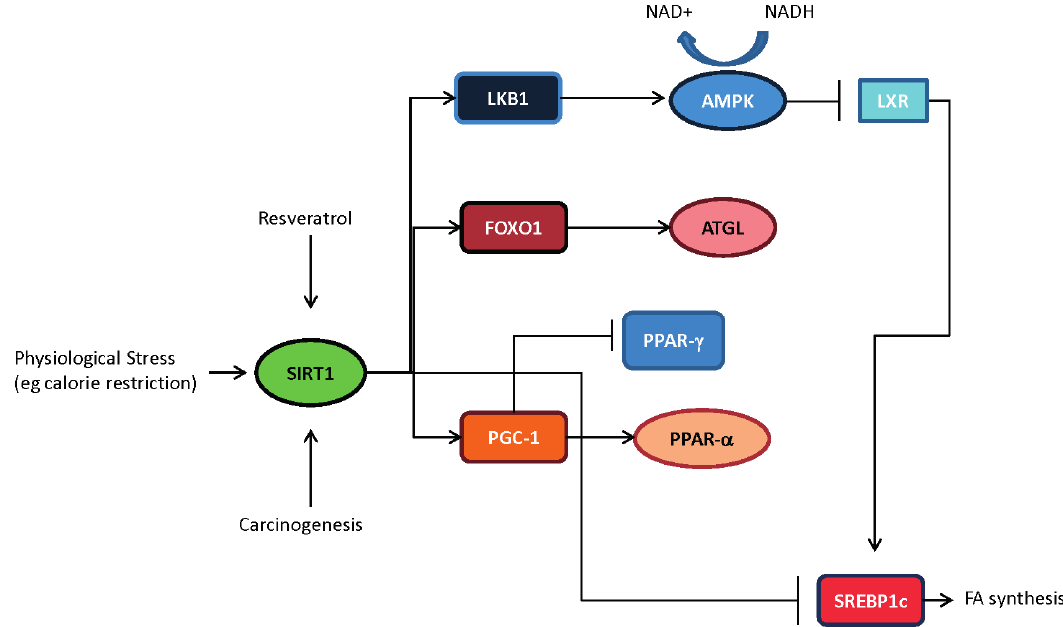
Figure 1. Key lipid regulatory pathways influenced by SIRT1 deacetylase activity.